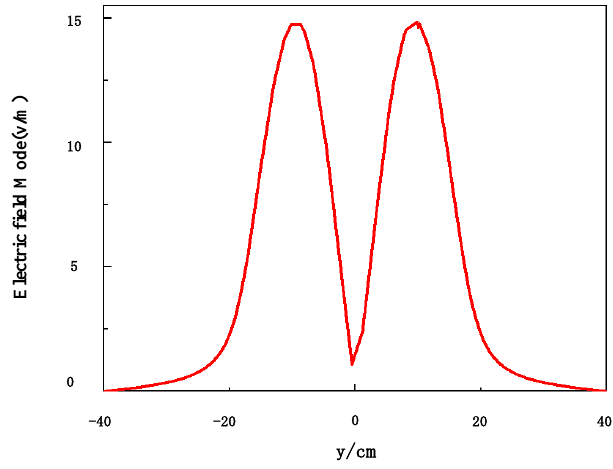
Figure 9. Electric field distribution on the yoz plane coupling center line.